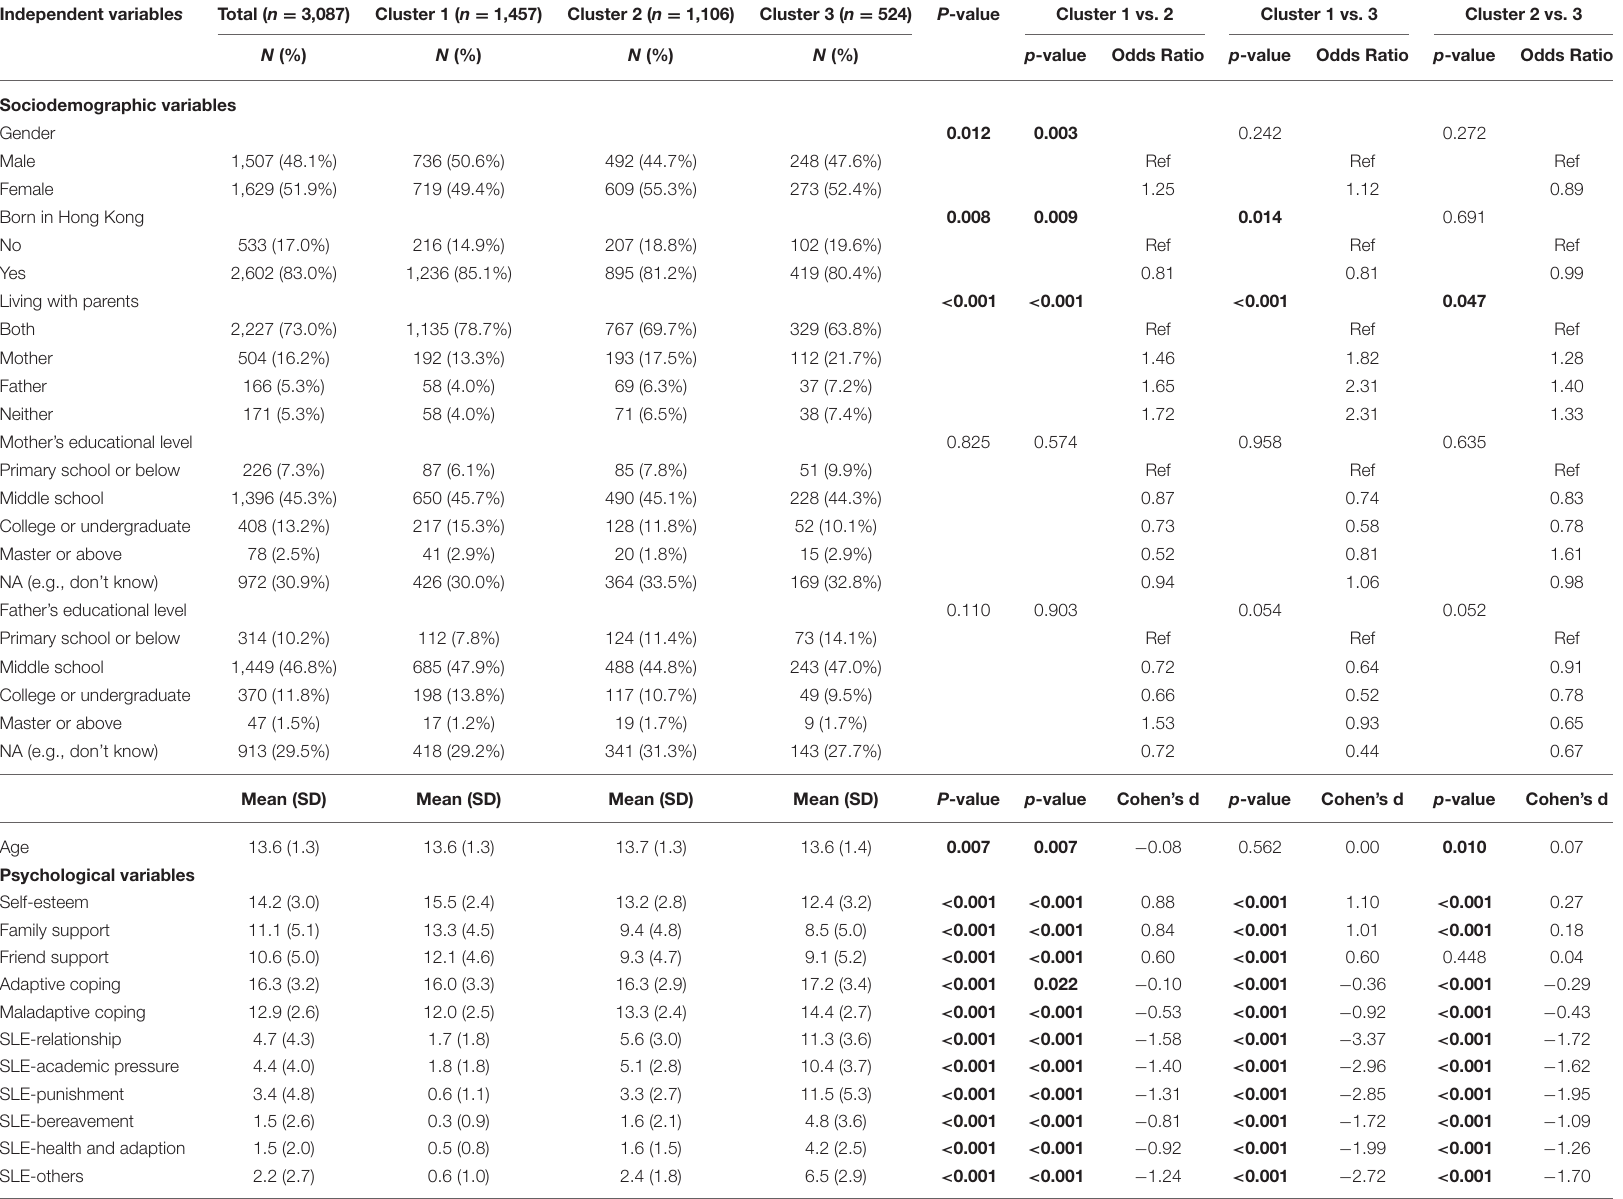
TABLE 1 | Comparison between the clusters in sociodemographic and psychosocial variables. Independent variable